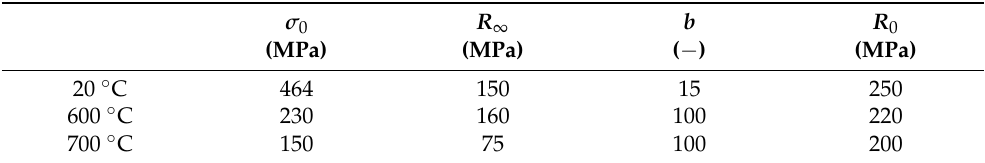
Table 9. Triaxiality, Lode parameter, and equivalent plastic strain at fracture for different tests and temperatures.